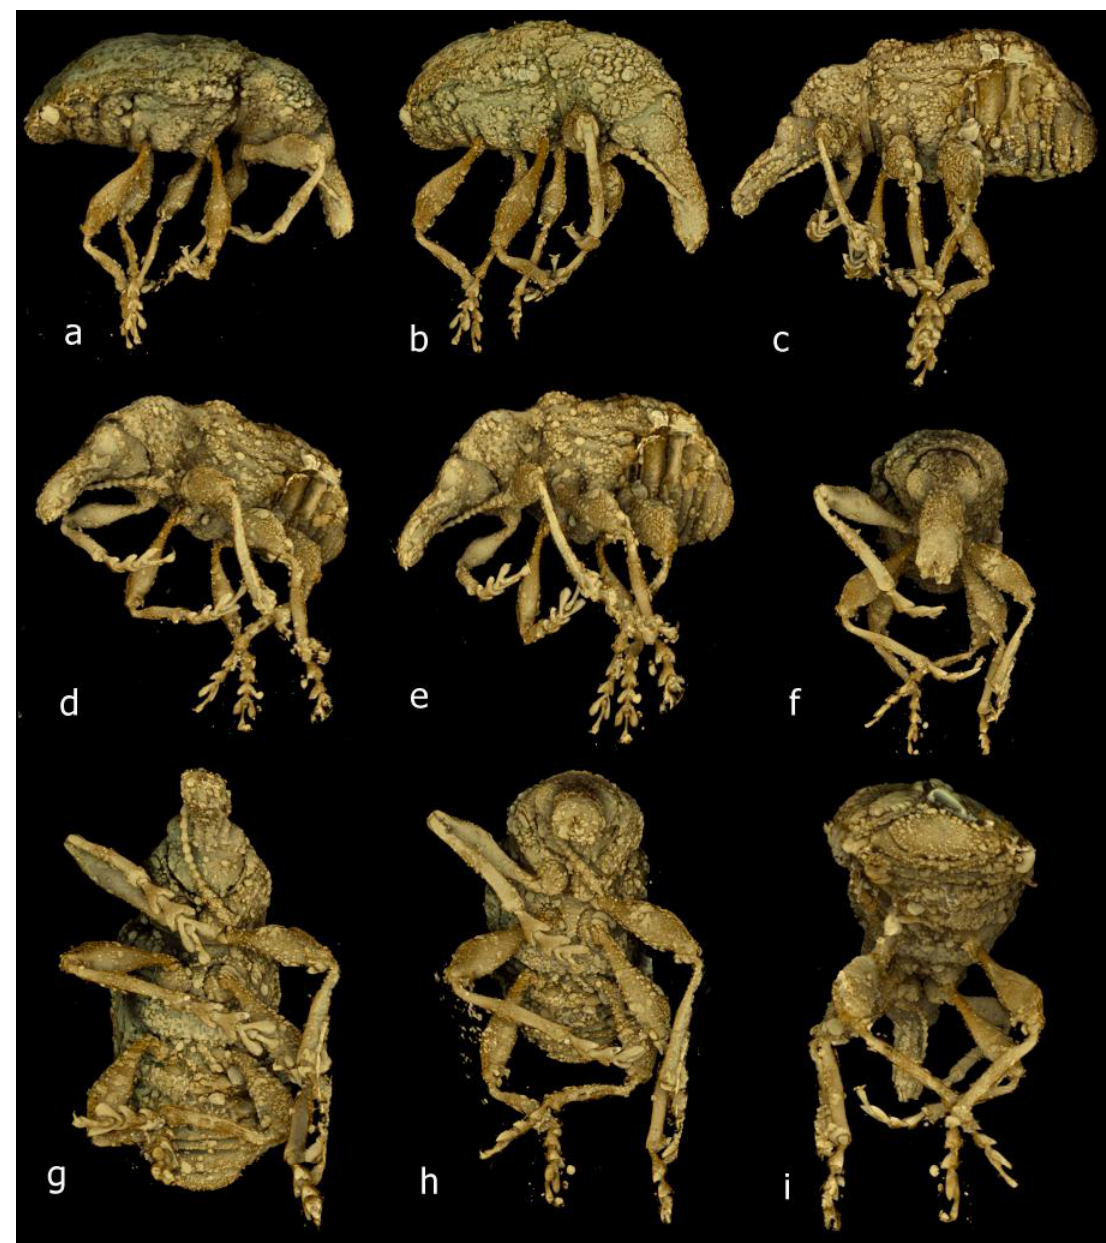
Figure 23. Calyptocis brevirostris sp. n., holotype. Habitus images extracted from micro-CT scanning reconstruction (see also Video S1). Right lateral ( a ); right lateral oblique ( b ); left ventral oblique ( c ); left lateral oblique ( d ); left lateral ( e ); frontal ( f ); ventral ( g ); frontal oblique ( h ); posterior oblique ( i ).